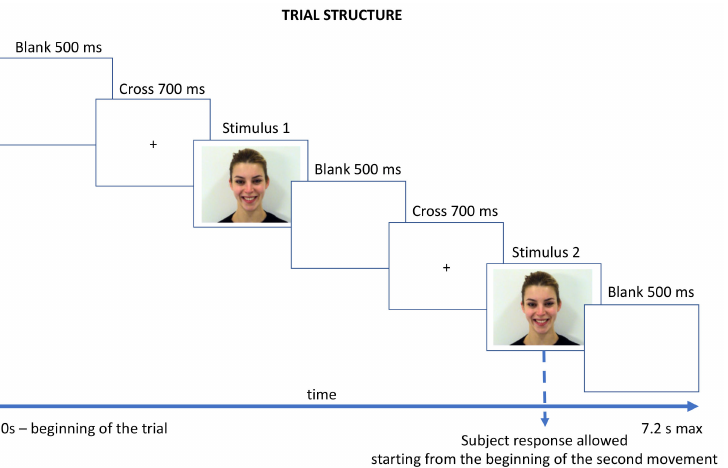
Figure 2. The trial sequence in which the two stimuli varying in speed were presented for comparison. Stimulus 1 and stimulus 2 had an equal total duration, but they differed in the duration of the dynamic part (see Figure 1); i.e., the second stimulus could represent a faster or slower facial movement compared to the first. Participants were instructed to press the keyboard space bar in order to start each trial and then to answer as soon as they identified which one of the two movements presented was faster by pressing the “1” or “2” button on the keyboard. Instructions were given at the beginning of the task and were explained again throughout the training session; no more text or instructions appeared during the trials. Responses were allowed starting from the beginning of the second movement, and within 5 s following the end of the second stimulus presentation. The trial ended after the participant response or after 5 s following the presentation of second stimulus (even if the subject did not